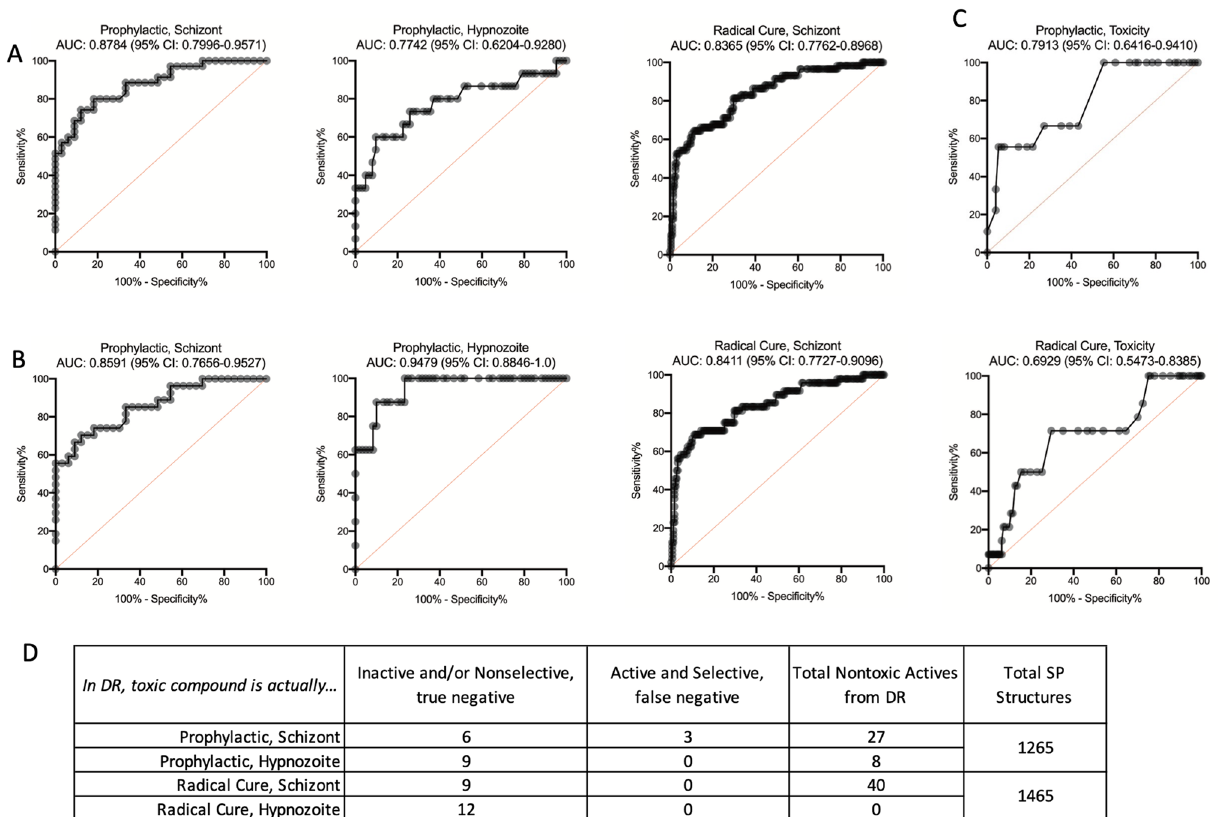
Figure 4. Receiver-operator characteristic (ROC) analyses of screen data. ROC curves were calculated for all compounds from the Reference Compound Library, Malaria Box, Pathogen Box, and Stasis Box for which dose response (DR) data were collected as part of this report, area under curve (AUC) and 95% CI are indicated. ( A ) ROC curves of Prophylactic or Radical Cure activity against schizonts or hypnozoites for compounds exhibiting unambiguously active or inactive curves in DR assays, regardless of possible toxicity. ( B ) ROC curves of Prophylactic or Radical Cure activity against schizonts or hypnozoites for compounds exhibiting unambiguously active or inactive curves and no toxicity at 10 μM in DR assays. ROC curves were not calculated for Radical Cure activity against hypnozoites because no hits were found from SP assays. ( C ) ROC curves of compounds found toxic at 10 μM in Prophylactic and Radical Cure DR assays. ( A – C ) Red line indicates a random assay. ( D ) Table quantifying all compounds considered putative hits in SP assays which were found toxic at 10 μM in DR confirmation assays. Only 3 compounds with Prophylactic activity against schizonts exhibited a selectivity window in DR confirmation, all other compounds did not exhibit selective